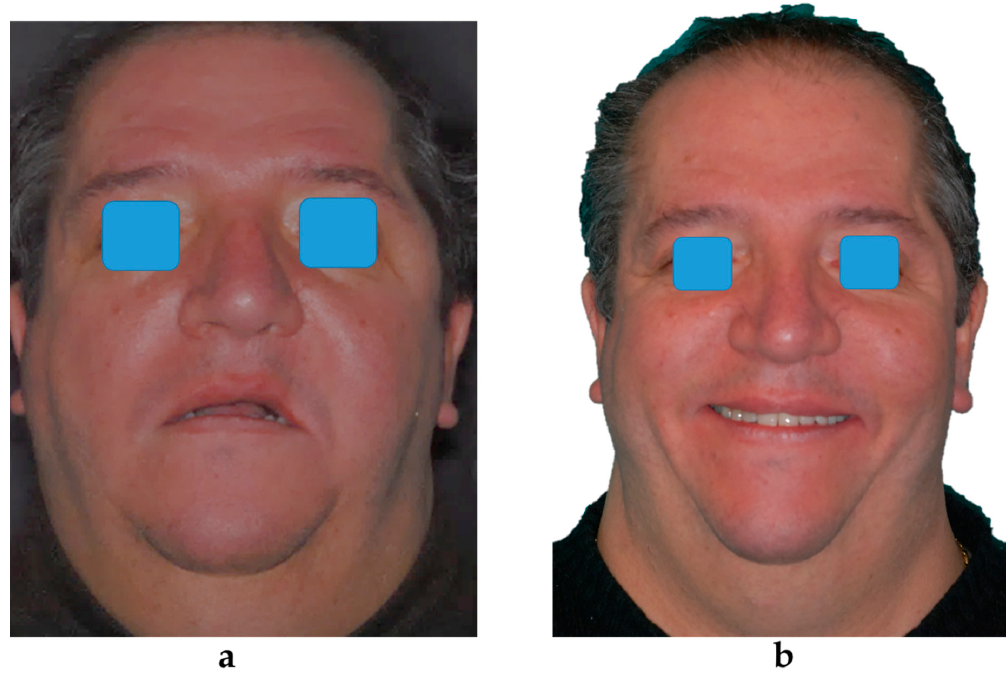
Figure 8. Preoperative ( a ) and postoperative ( b ) facial appearance.